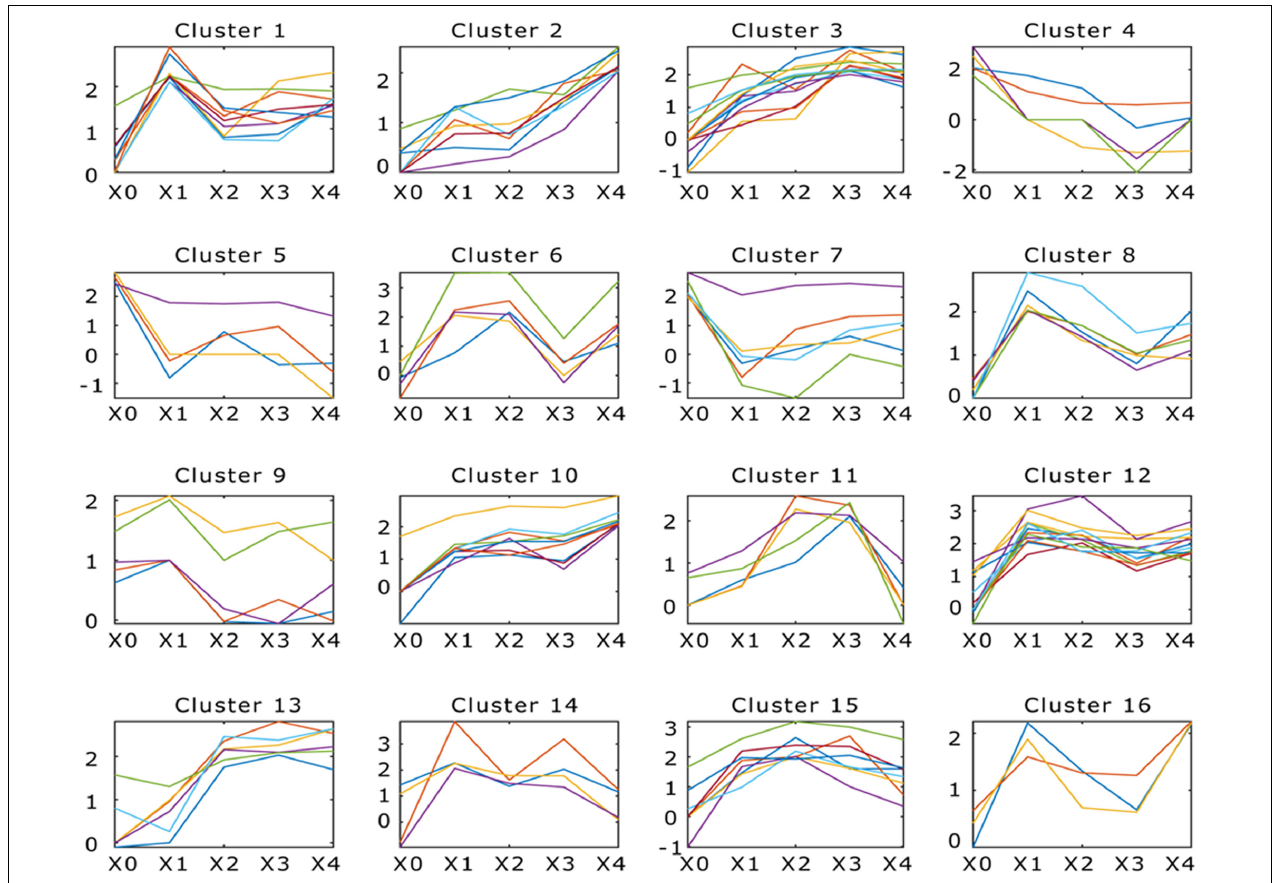
FIGURE 4 | Dynamic progression of Morchella conica SH transcriptome in different development stages. K-means clustering showing the expression profile of the M. conica SH transcriptome. Sixteen clusters were identified and presented along the five stages (X0, X1, X2, X3, and X4) from 9,203 differentially expressed genes; genes of each cluster were listed in Supplementary Table 21